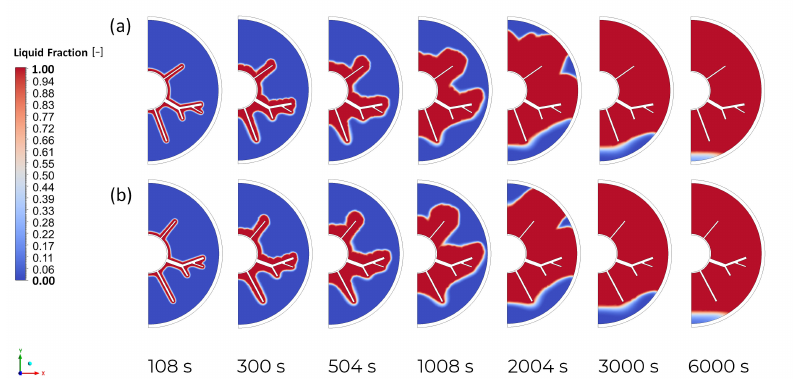
Figure 6. Liquid fraction contours during melting for ( a ) DP No. 4, ( b ) DP No. 18.